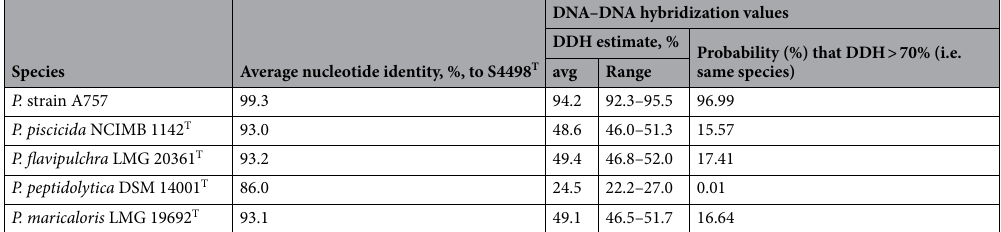
Table 2. In silico DNA–DNA hybridization values of four type strains of Pseudoalteromonas and strain A757 as compared to Pseudoalteromonas galatheae S4498 T . DDH values are shown using formula 2 of the DSMZ GGDC Genome-to-Genome Distance Calculator 2.1.